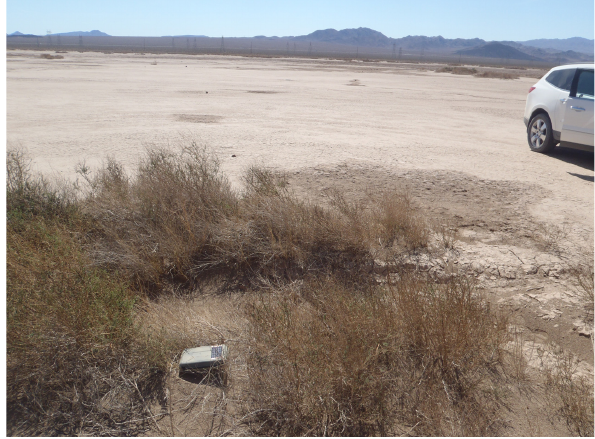
Fig. 5. Sagebrush patch on the playa with solar-powered datalogger